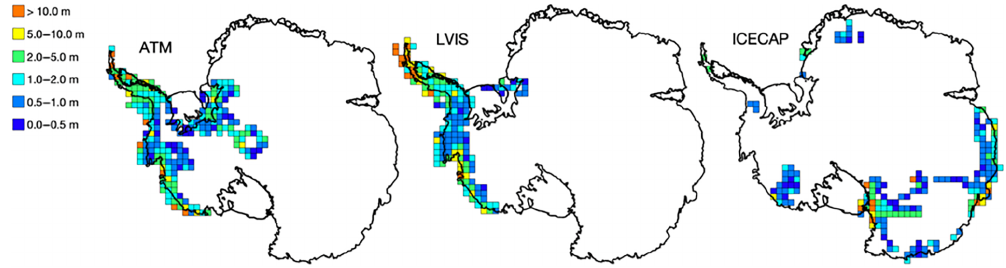
Figure 8. Root mean square of point elevation differences by mosaic tile between REMA and each of the three NASA Operation IceBridge lidar systems. Only measurements collected less than 1 year apart are used.